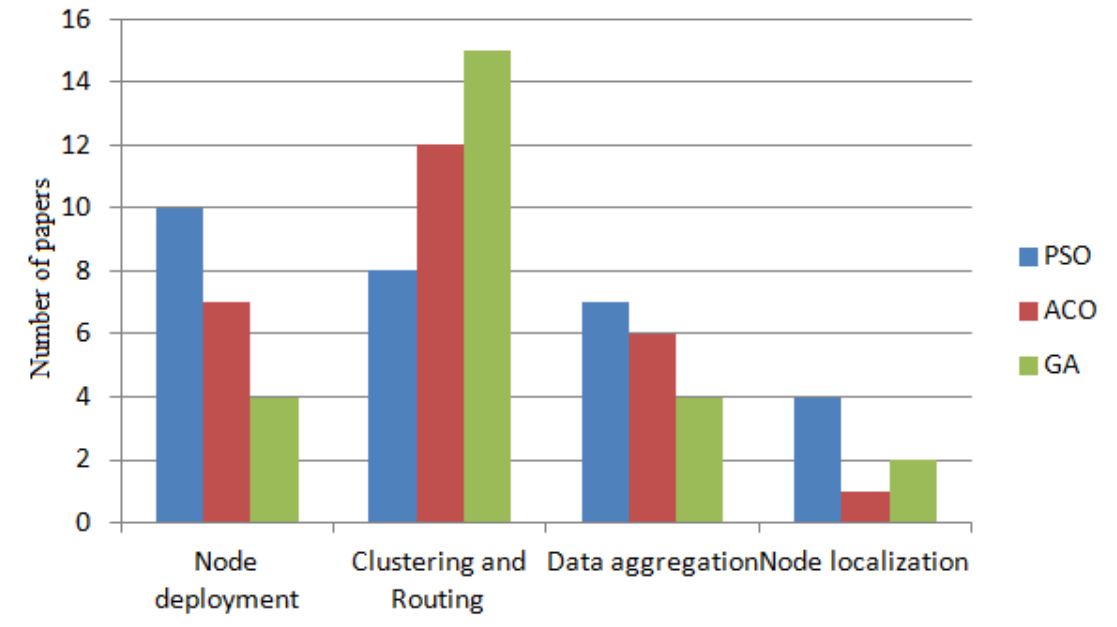
Figure 9. A representation of number of papers published addressing optimization problems in WSN using bio-mimetic methods